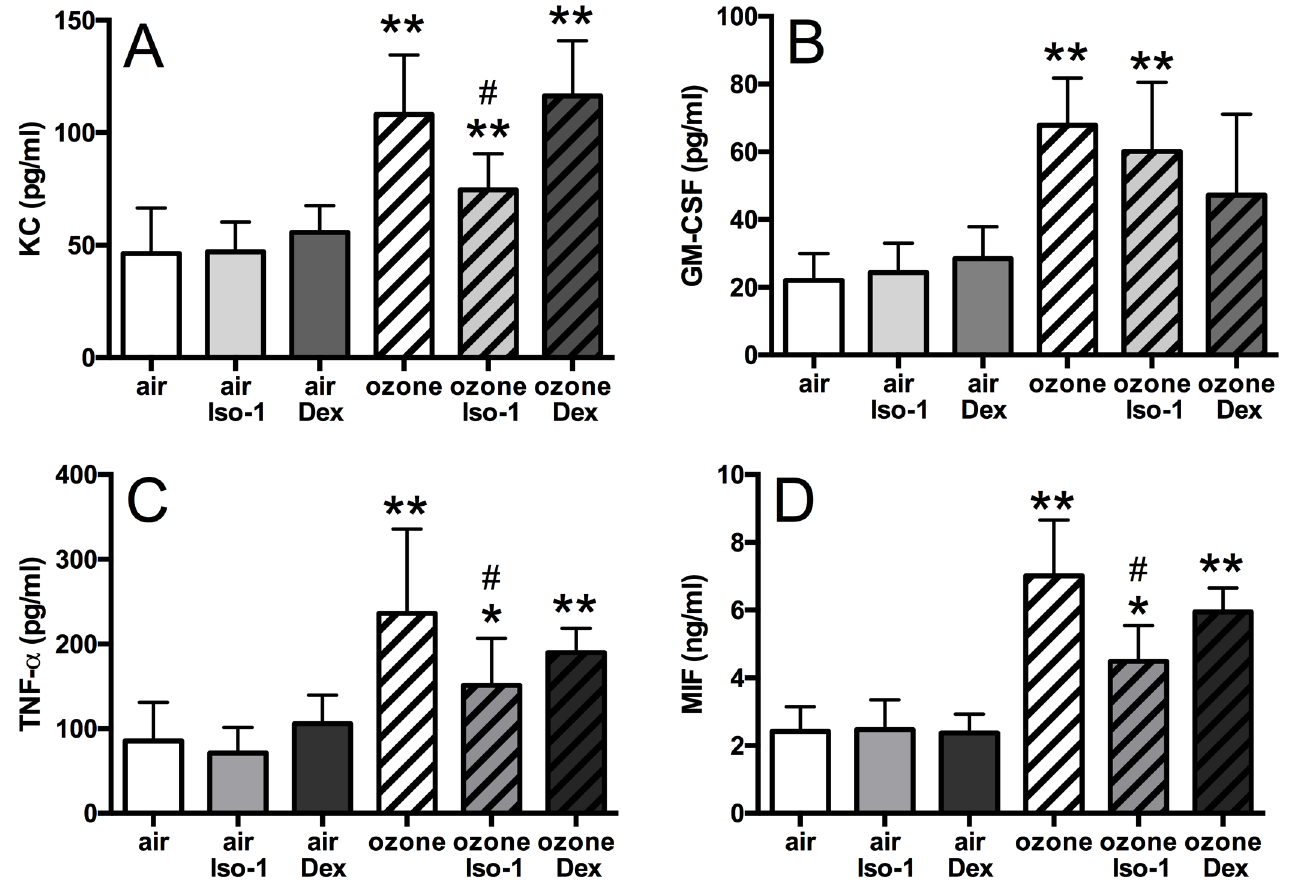
Fig 4. Effect of ISO-1 and dexamethasone on ozone-induced BAL inflammation. Cytokine protein levels in mouse BAL of ozone exposed and ISO-1- or dexamethasone-treated mice measured by ELISA. KC (A), GM-CSF (B), TNF- α (C) and MIF (D). Data are expressed as mean ± SD for 6 animals per group. * p < 0.05 and ** p < 0.01 compared to air controls, # p < 0.05 compared to ozone exposed group.